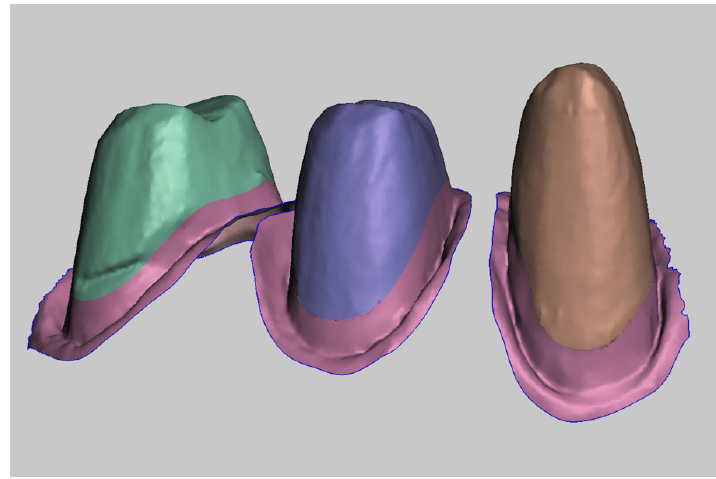
Figure 14. Deriving a unified file from two separate parts.